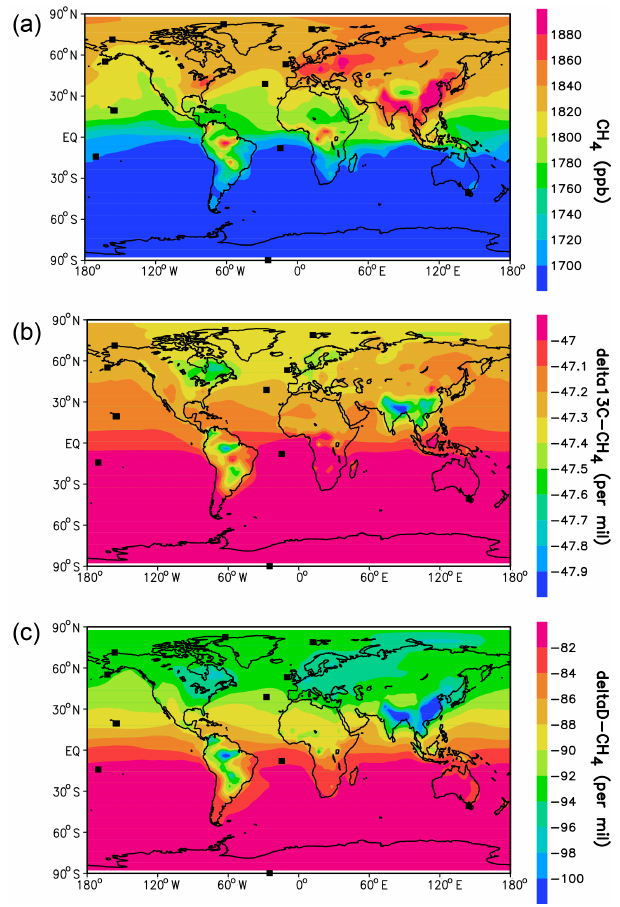
Figure 3. Modelled global annual mean surface distributions of (a) CH 4 , (b) δ 13 C-CH 4 and (c) δ D-CH 4 for the p-TOMCAT BASE scenario. Locations of measurement data sites used in this study are marked as black squares.